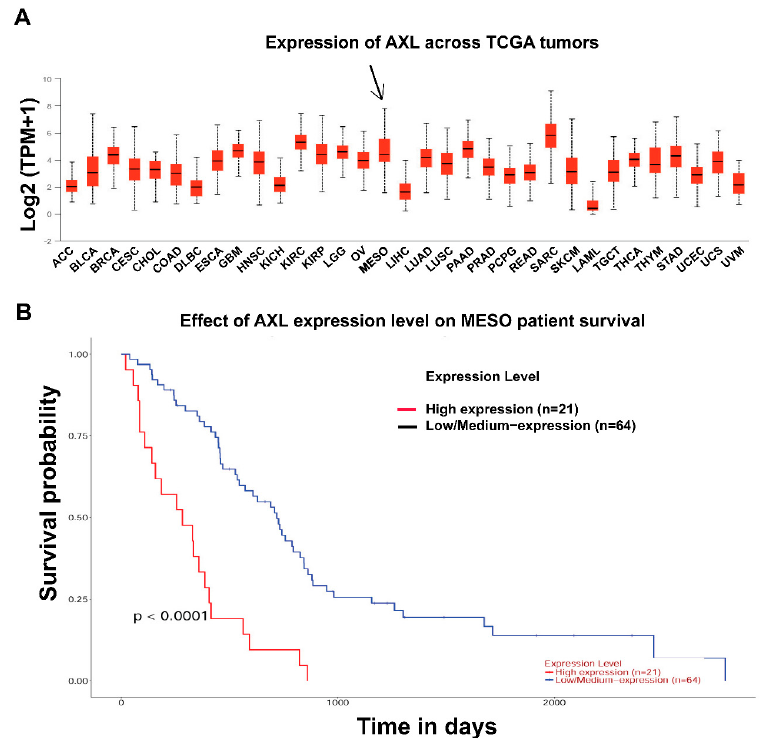
Figure 1. AXL overexpression and survival analysis in mesothelioma. ( A ) TCGA gene expression profiling